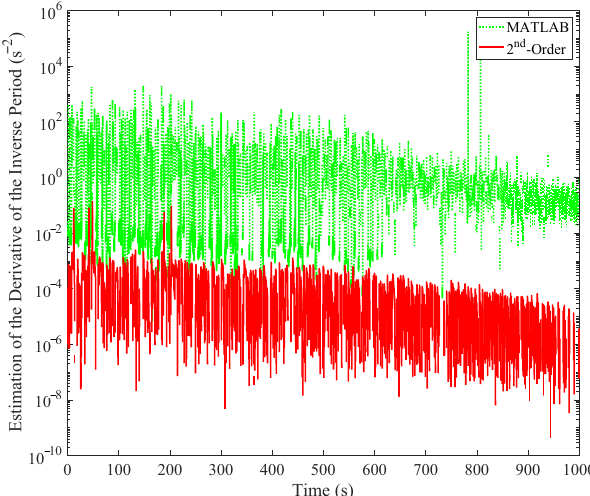
Figure 5. Amplitude of the derivative of the inverse period.